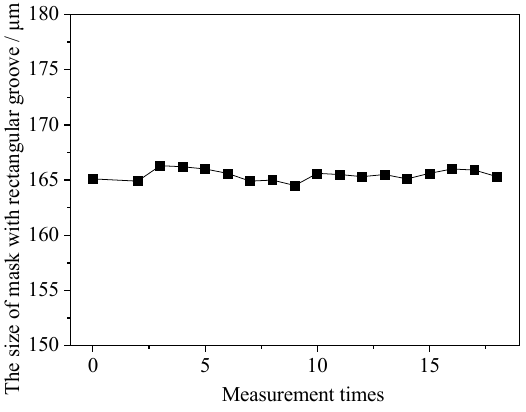
Figure 7. Results of preparing mask with rectangular grooves: (a) two-dimensional overall view; (b) local three-dimensional topography.